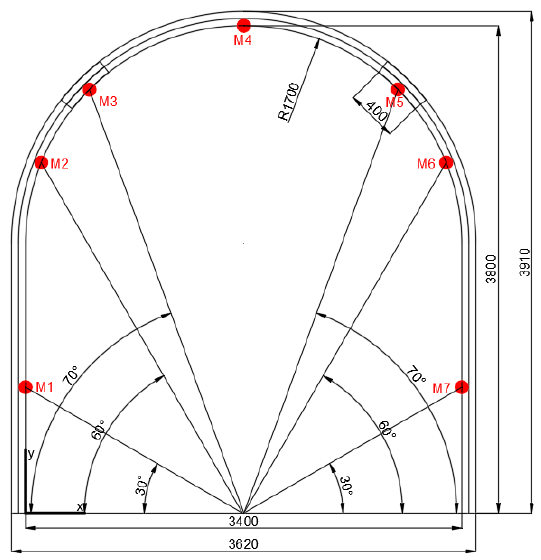
Figure 4. Steel arch support with positions of the markers.